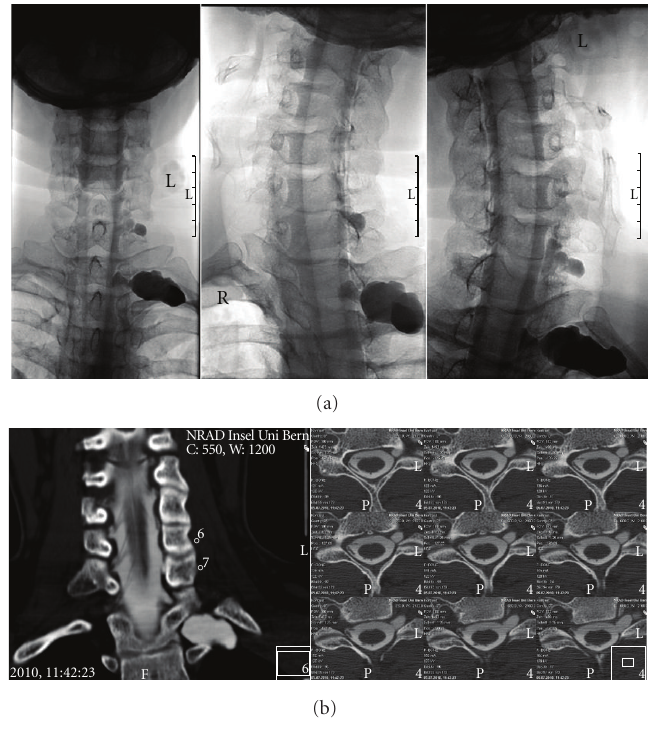
Figure 7: Cervical root avulsion after motorcycle accident. (a) Myelography shows traumatic pseudoceles C7-D1. Rootlets are not discernible. (b) Thin-section (1.25 mm) myelo-CT and reformatted coronal images clearly show complete avulsion of ventral and dorsal rootlets.